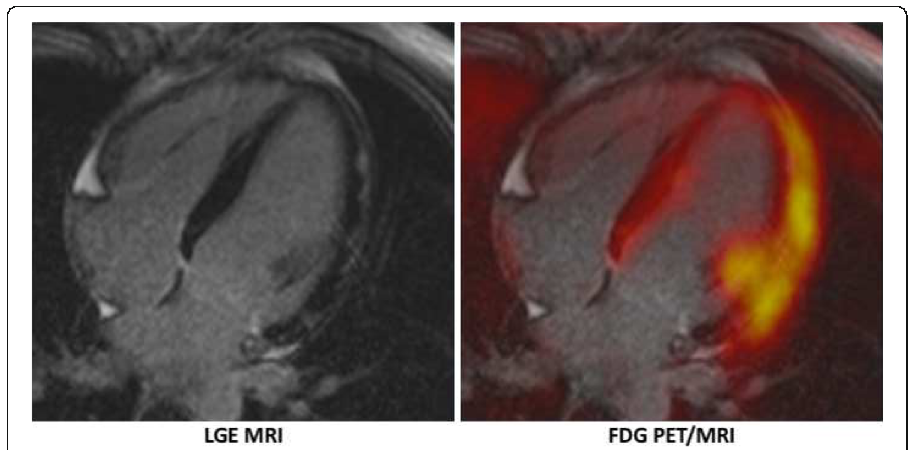
Fig. 6 FDG PET/MRI in a case of myocarditis. Subepicardial, mostly band-shaped late gadolinium enhancement (LGE) on MRI in the lateral wall of the left ventricle. The FDG uptake on PET clearly exceeds LGE MRI indicating active infection exceeding the scarred